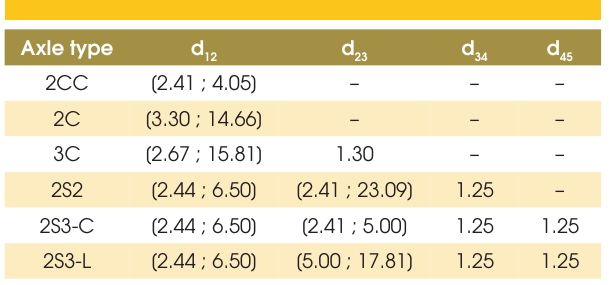
Table 5 – Some deterministic values and